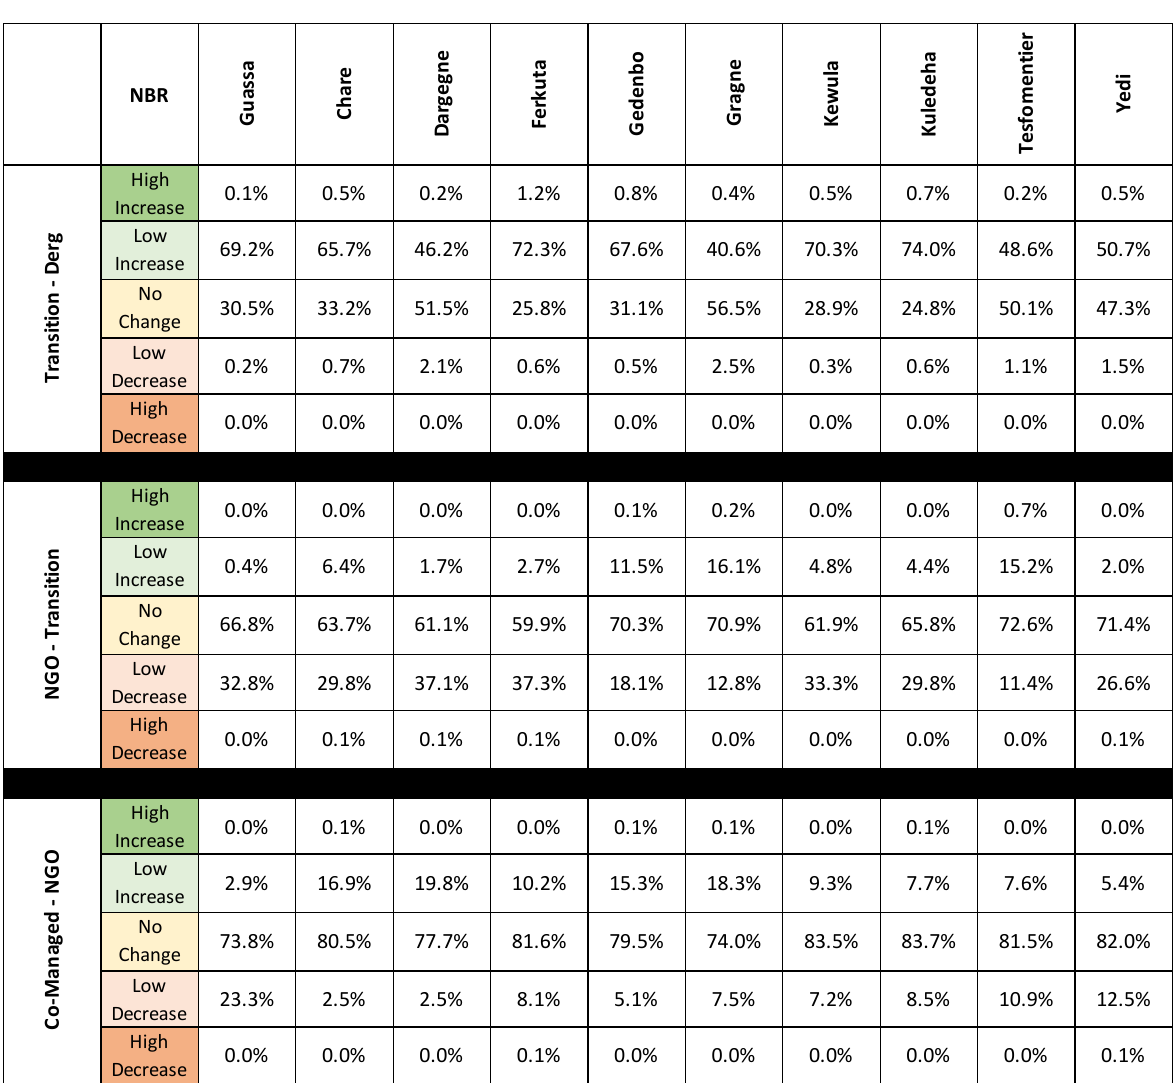
Table A1.3. The percent of land area and direction of vegetation change (from NBR values) for each kebele and the Guassa area across each period of political and management history (wet